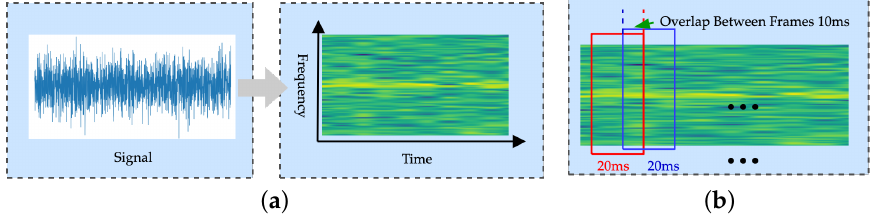
Figure 6. Data collation of UWA signals: ( a ) the time–frequency two-dimensional form of the received signal; ( b ) the data framing strategy for the pre-processing